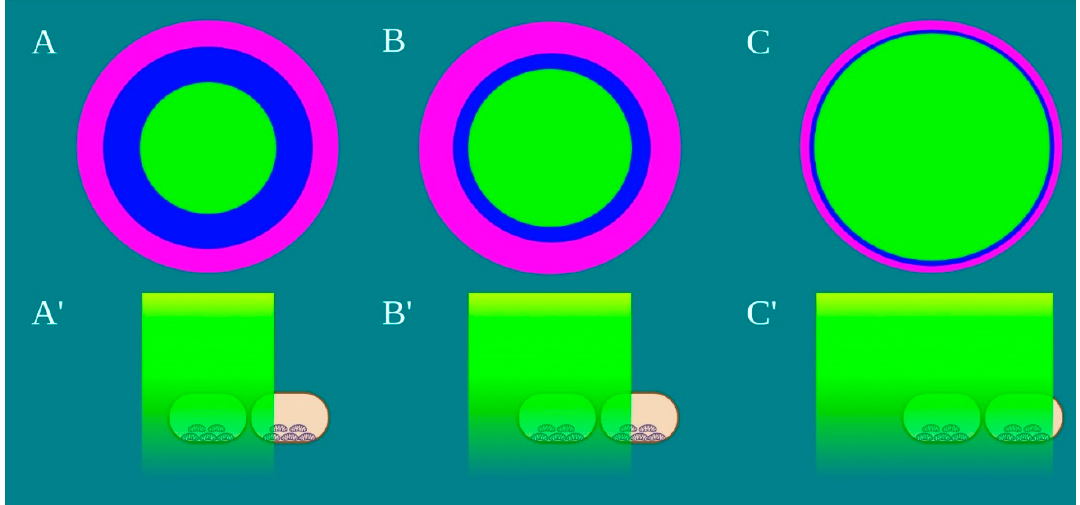
Figure 4. Schematic representation of the laser beam profile ( A – C ) and the drop’s area irradiated by the power density of 1 W/cm 2 , green colour, ( A’ – C’ ) Image created with BioRender.com.